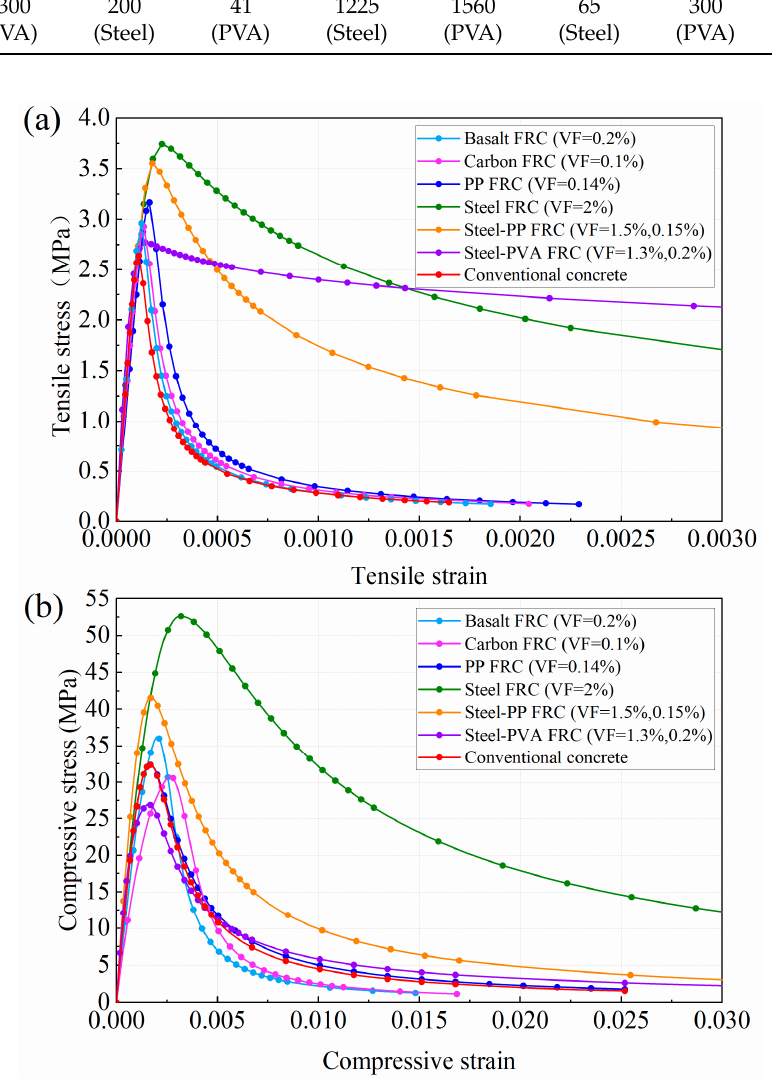
Figure 5. The stress–strain relationship of FRC: ( a ) Uniaxial compressive stress-strain curves; ( b ) Uniaxial tensile stress-strain curves.